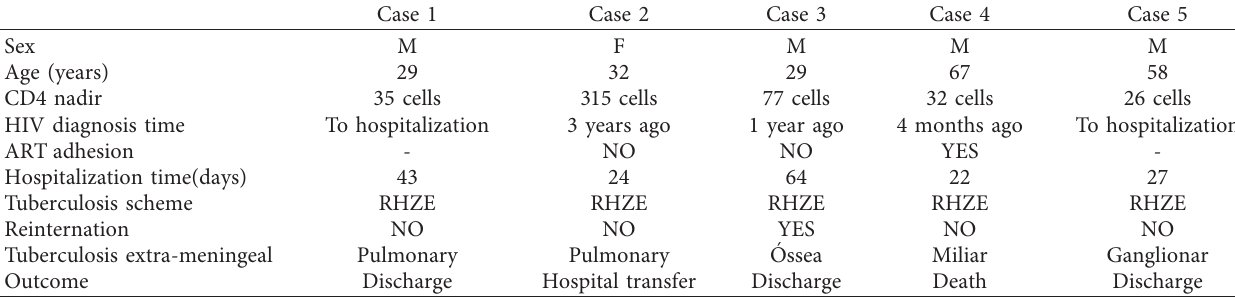
Figure 1: Nuclear magnetic resonance in case 2. (a) Hypersignal in the cerebral turns, bilaterally high convexity in T2 FLAIR. (b) Moderate dilated supratentorial ventricular system, associated with periventricular white matter hypersignal, probable CSF transudation on T2 FLAIR. (c)-(d) After administration of venous contrast, intense diffuse meningeal enhancement markedly in the regions of the cisterns of the base, axial T1, and Vol T1 3D, Table 1: Epidemiological profile of patients with tuberculous meningitis.